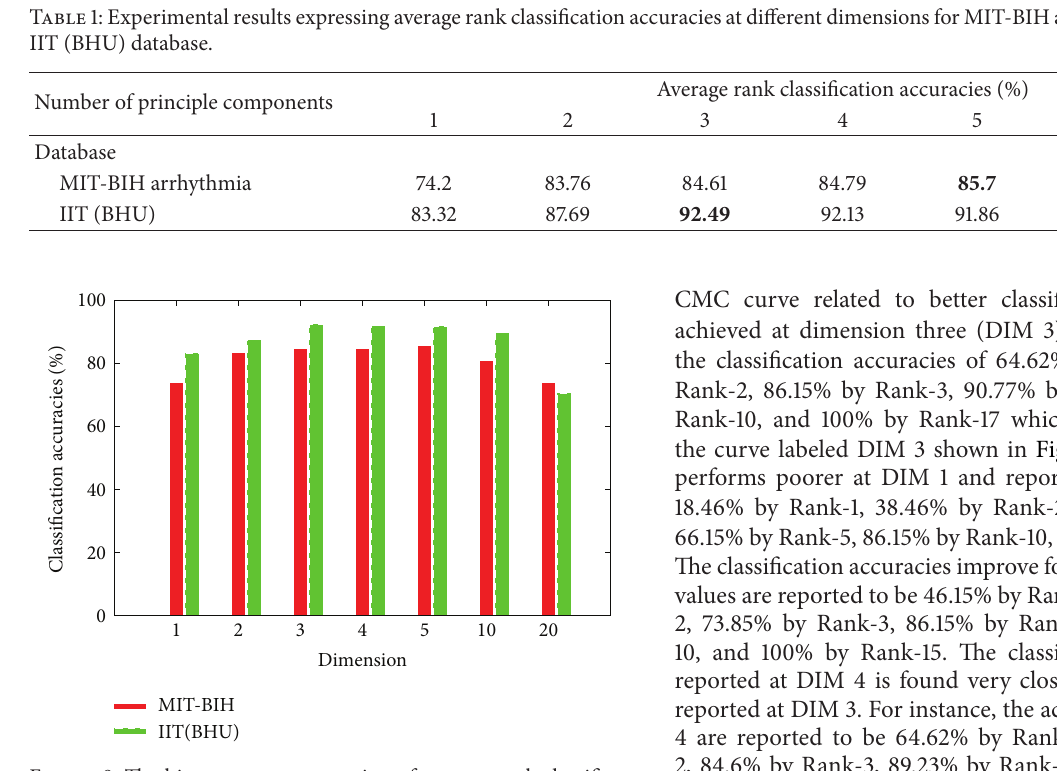
Figure 8: The histogram representation of average rank classifica- tion accuracies obtained for the subjects of MIT-BIH arrhythmia database and IIT (BHU) database. The performance depends on the considered eigenbeats